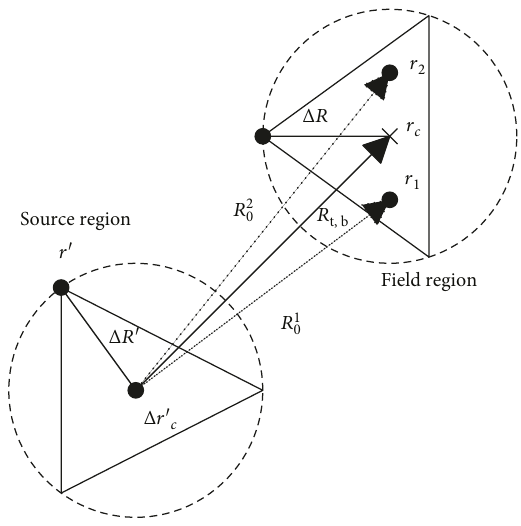
Figure 1: The sketch of the distances for the retarded Taylor